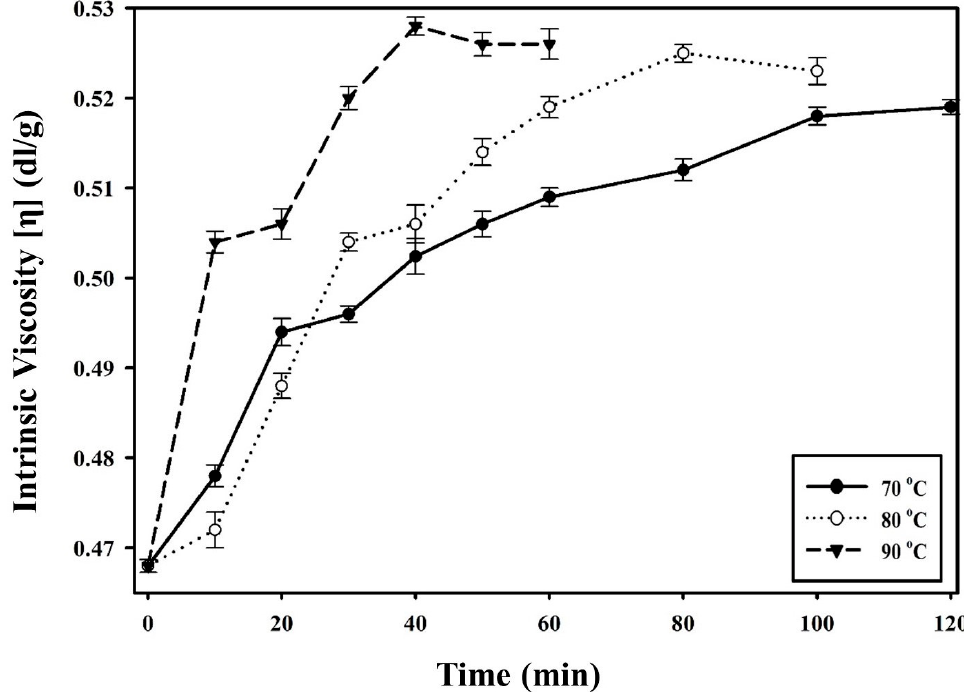
Figure 4. Change in intrinsic viscosity of PBSeT samples during the SSP process at different temper- atures.